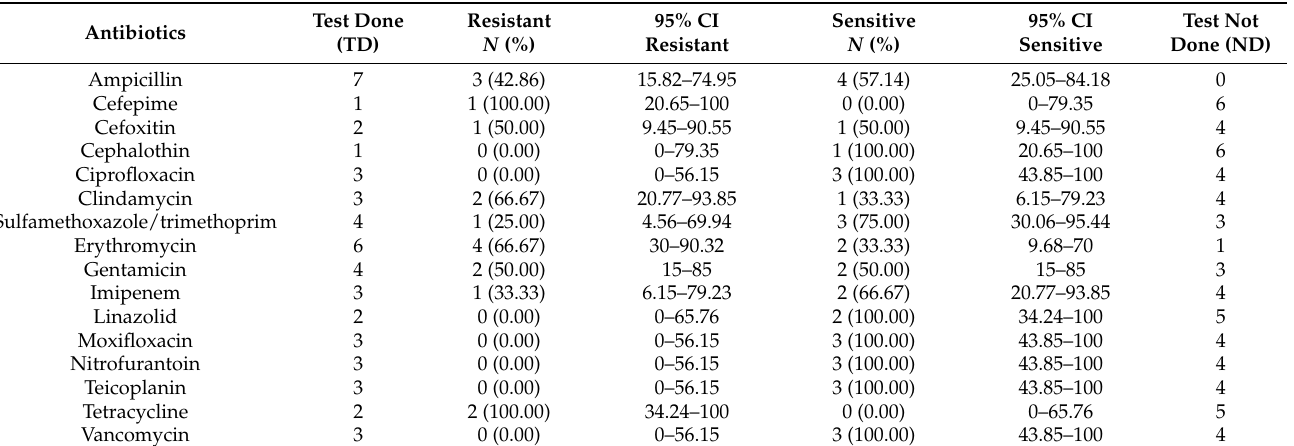
Table 5. Susceptibility pattern of E. faecalis in pediatric UTI patients.